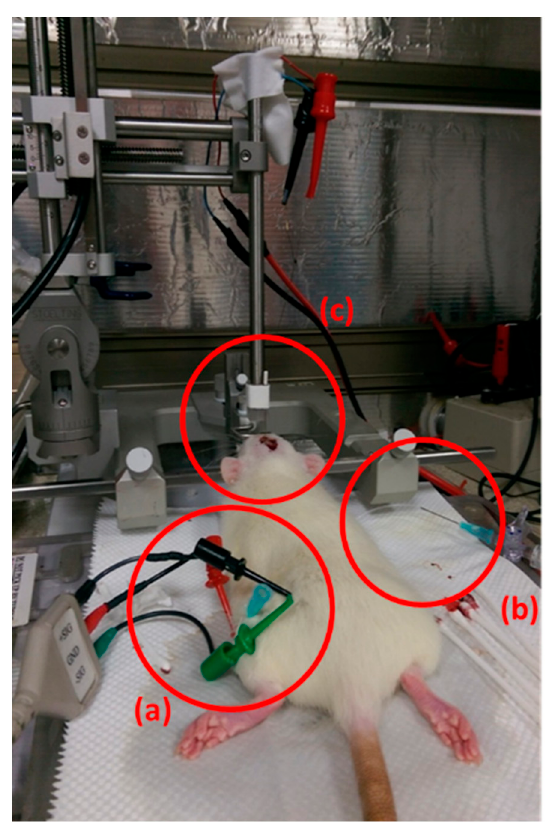
Figure 2. Surgical procedures performed in traumatic brain injury (TBI) deep-brain stimulation (DBS) rats ( a ) external urethral sphincter signal measuring electrodes, ( b ) bladder pressure measurement and micro tape fixed injection lines, ( c ) electrode after the positioning in the target area to deliver DBS.